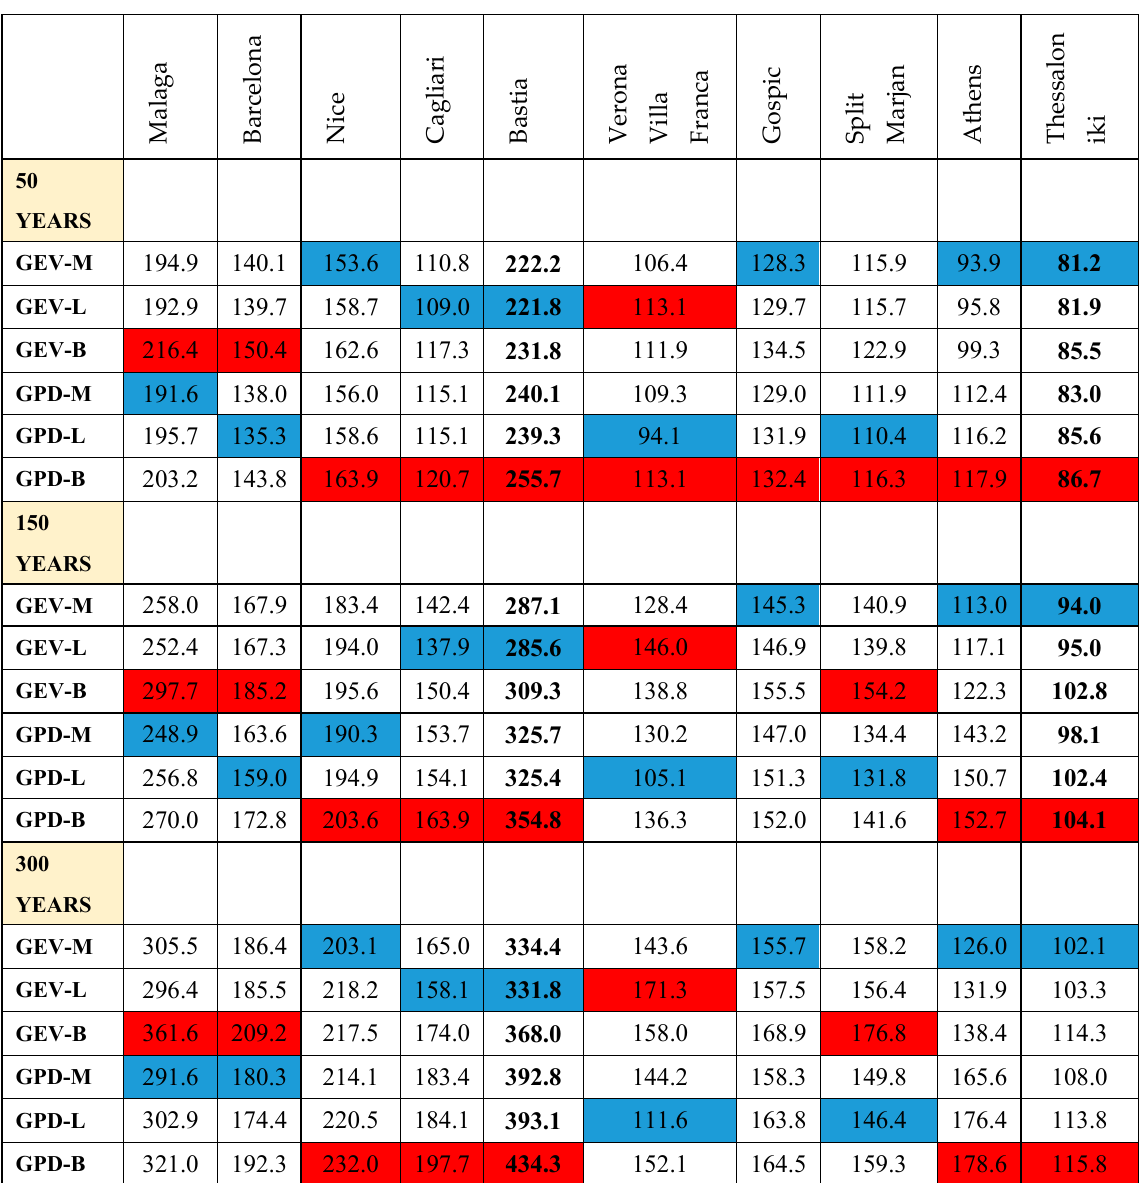
Table 2. The precipitation return levels for the 10 stations and for three return periods (50, 150 and 300 years). The red cells shows the highest values of each station while the blue shows the lowest